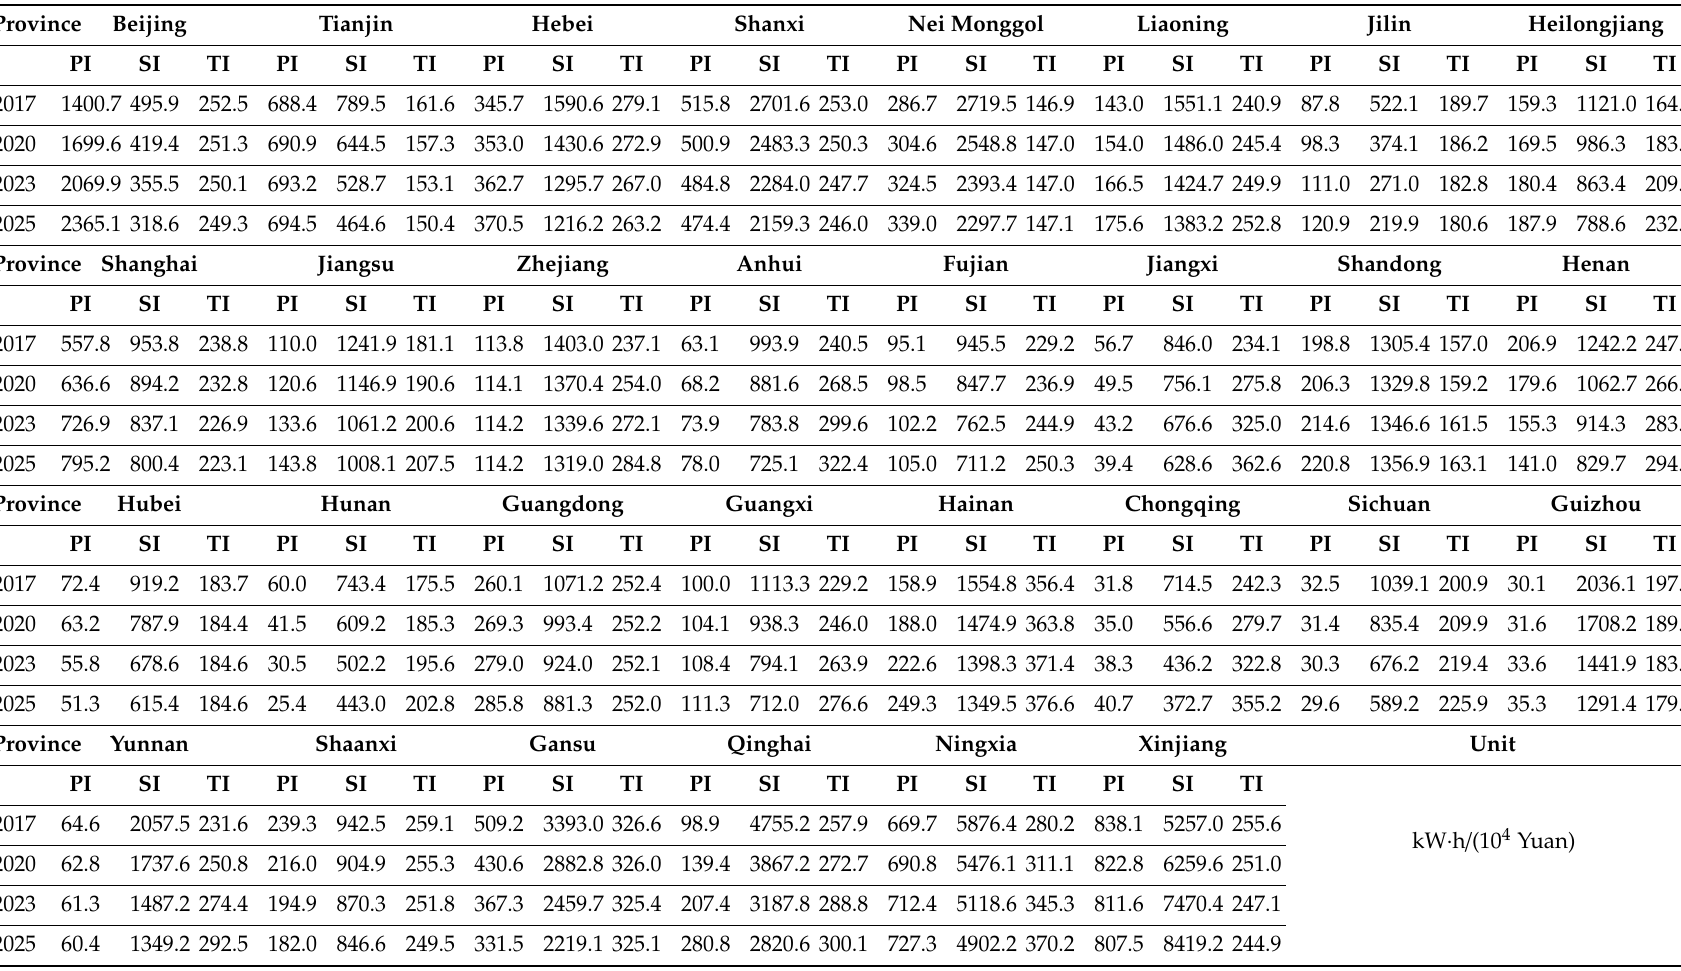
Table A4. Regional electric consumption of per unit gross domestic product (GDP) of the primary industry, secondary industry, and tertiary industry in 2017, 2020, 2023, and